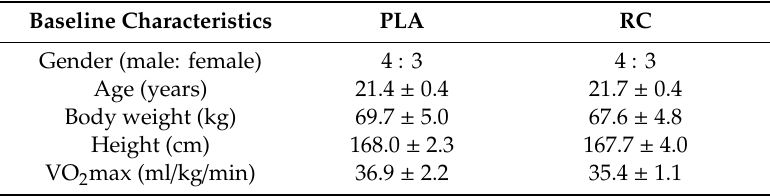
Table 2. Baseline characteristics of the participants.